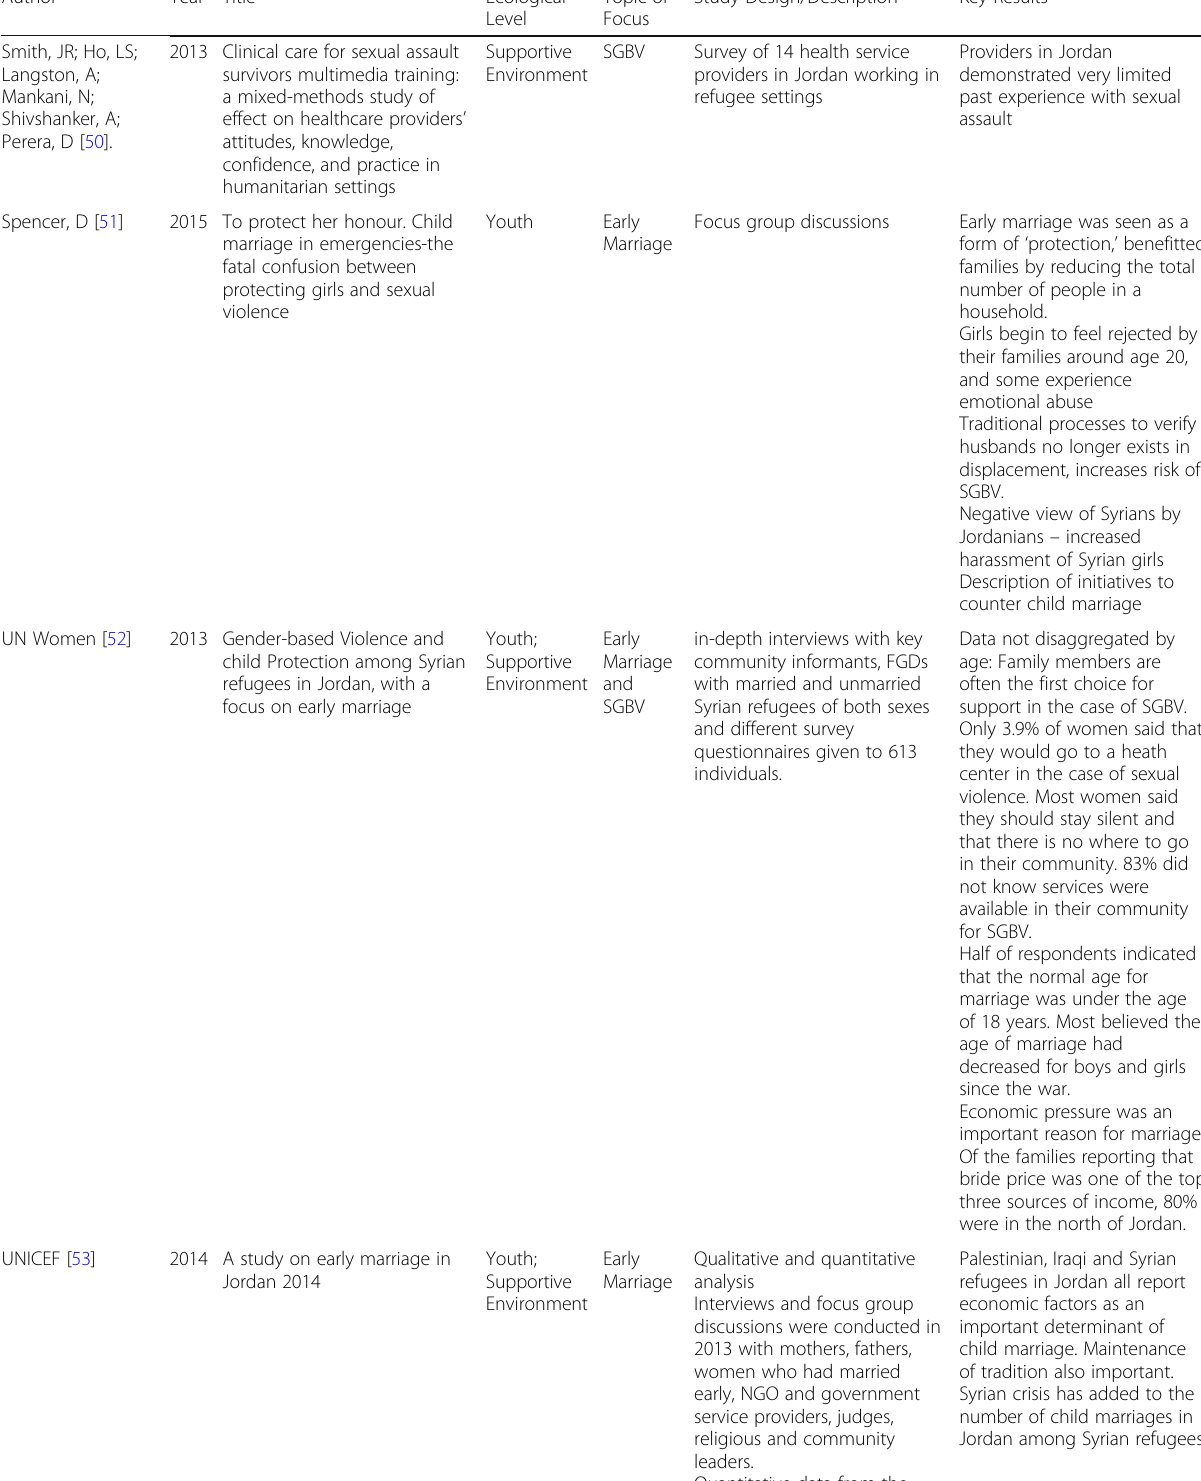
Table 1 Summary of the 27 documents included in the analysis according to ecological level and topic of focus pertinent to sexual- and gender-based violence and early marriage among youth in Jordan